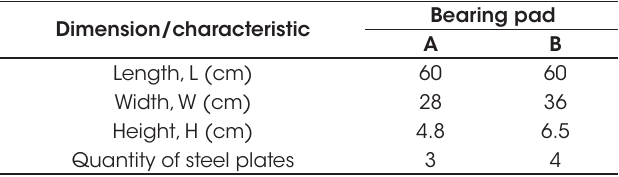
Dimensions and characteristics of the